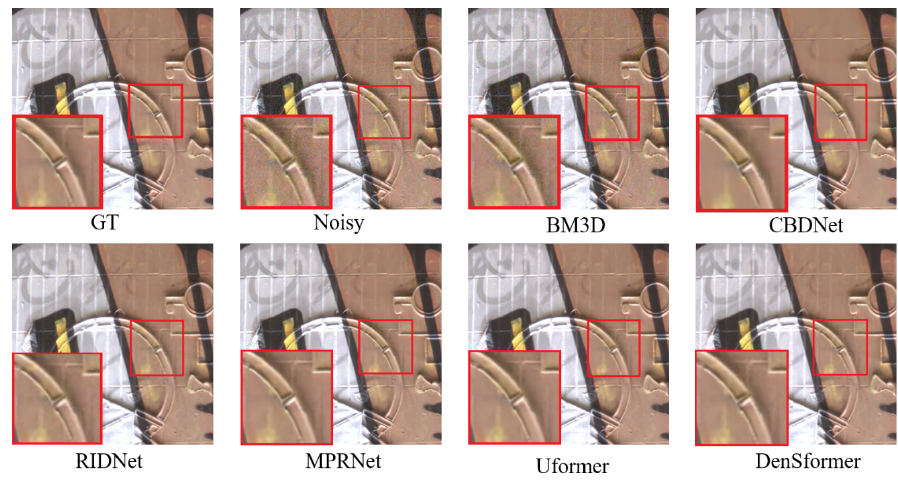
Figure 6. Denoising results of different existing methods from DnD .